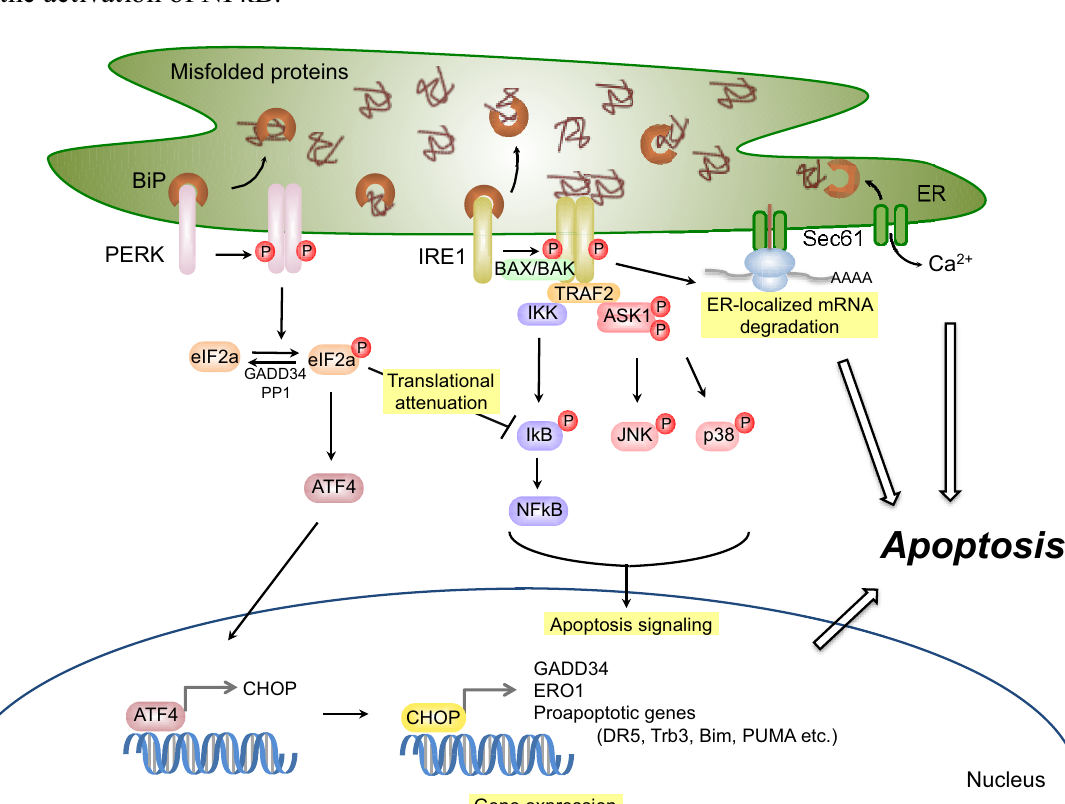
Figure 2. Apoptosis signaling under ER stress conditions. Prolonged or severe ER stress, as well as dysfunction of the unfolded protein response (UPR), induces apoptosis signaling, primarily through the IRE1 and PERK pathways. In the IRE1 pathway, activated IRE1 recruits TRAF2 and ASK1 on the ER membrane and activates the ASK1-dependent apoptosis pathway. In addition, the IKK- (cid:49)(cid:41)(cid:539)(cid:37)(cid:3)(cid:83)(cid:68)(cid:87)(cid:75)(cid:90)(cid:68)(cid:92)(cid:3)(cid:76)(cid:86)(cid:3)(cid:68)(cid:79)(cid:86)(cid:82)(cid:3)(cid:68)(cid:70)(cid:87)(cid:76)(cid:89)(cid:68)(cid:87)(cid:72)(cid:71)(cid:3)(cid:69)(cid:92)(cid:3)(cid:44)(cid:53)(cid:40)(cid:20) -TRAF2 and induces an apoptotic response. Proapoptotic Bcl-2 family members, Bax and Bak, interact with IRE1 and promote its RNase/kinase activity. Moreover, IRE1 induces ER-localized mRNA degradation. In the PERK pathway, ATF4 induced by the PERK- (cid:72)(cid:44)(cid:41)(cid:21)(cid:302)(cid:3) pathway upregulates the expression of CHOP, which in turn activates the transcription of GADD34, ER oxidoreductase 1 (ERO1), and many proapoptotic factors. GADD34 then promotes (cid:71)(cid:72)(cid:83)(cid:75)(cid:82)(cid:86)(cid:83)(cid:75)(cid:82)(cid:85)(cid:92)(cid:79)(cid:68)(cid:87)(cid:76)(cid:82)(cid:81)(cid:3)(cid:82)(cid:73)(cid:3)(cid:72)(cid:44)(cid:41)(cid:21)(cid:302)(cid:3)(cid:90)(cid:76)(cid:87)(cid:75)(cid:3)(cid:51) P1, canceling translational attenuation, and leads to an increase of protein loads into the ER. Furthermore, the translational attenuation of